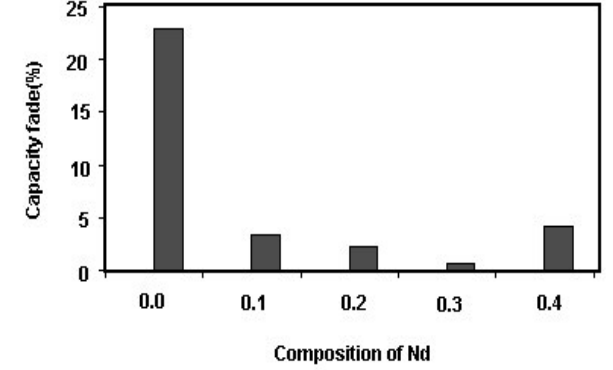
Figure 9. Capacity fading rate vs. in LiMn 2 O 4 and LiNd x Mn 2-x O 4 (x = 0.1, 0.2, 0.3 and